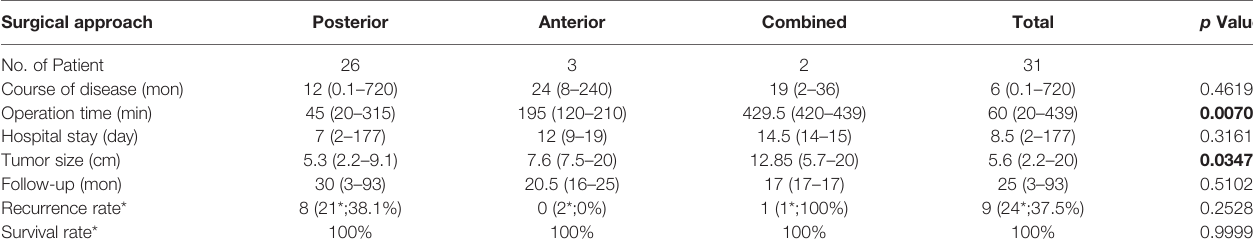
TABLE 4 | Comparison of three surgical approaches. Surgical